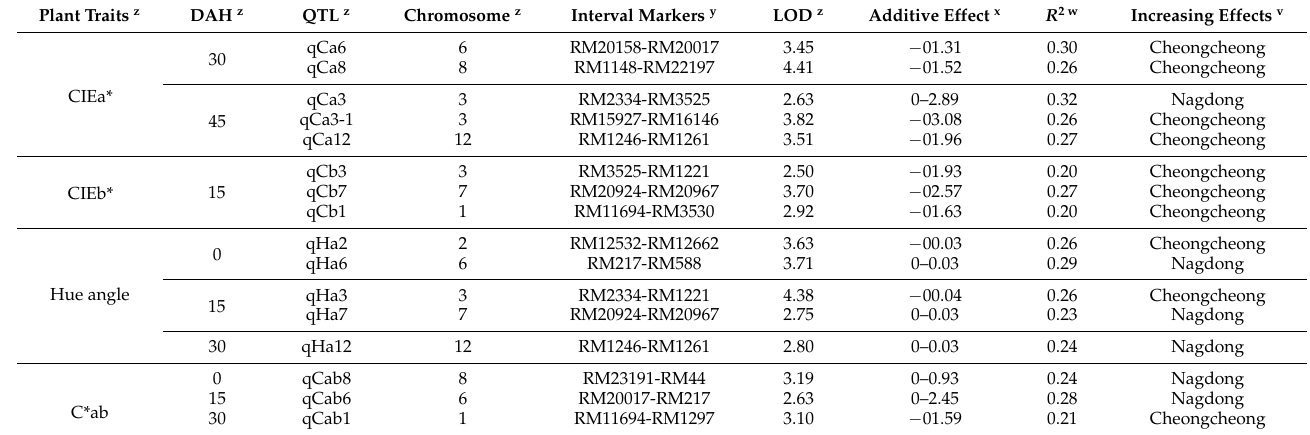
Table 3. QTLs related to the photosynthesis efficiency-related traits of CNDH